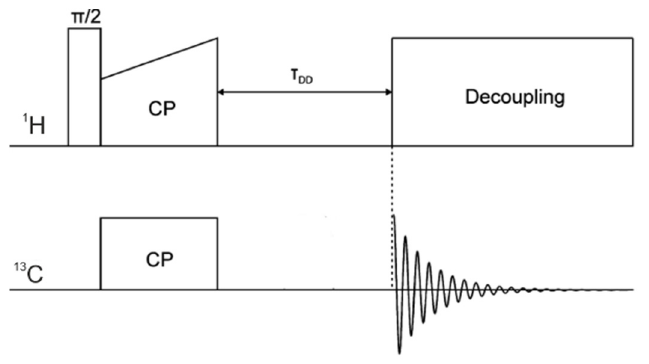
Figure 7. 13 C DD CP MAS NMR pulse sequence.